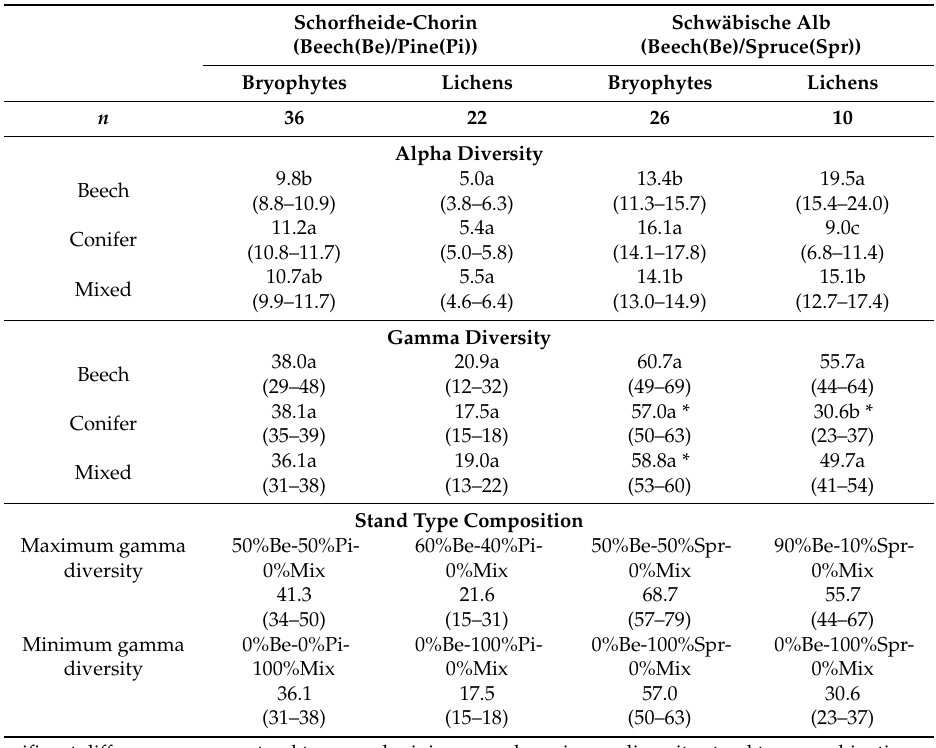
Table 3. Alpha and gamma diversity (species richness) of bryophytes and lichens in pure beech, pure conifer and mixed stands (=corners of the triangel in Figure 1), and the composition of pure and mixed stands that supports maximum and minimum gamma diversity of bryophytes and lichens in Schorfheide-Chorin and Schwäbische Alb. Given are mean values of 1000 resamplings based on the number of plots ( n ) per resampling. Minimum and maximum resampling values are given in parenthesis.